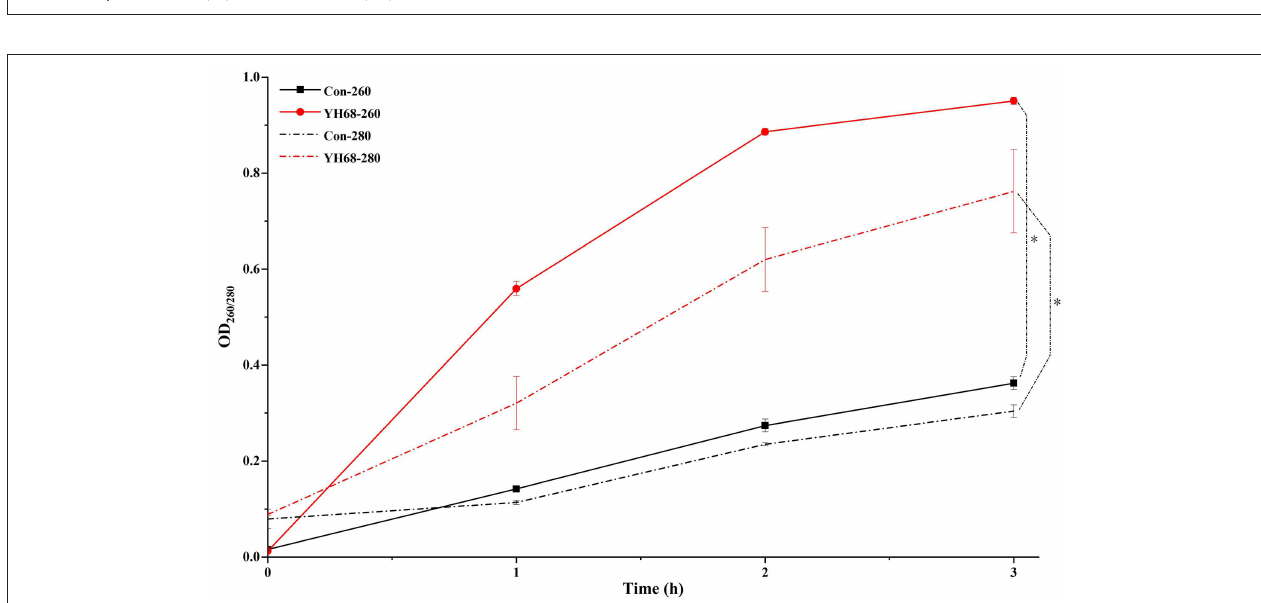
FIGURE 7 | Extracellular UV-absorbing materials from C. difficile ATCC 9689 cells (* P < 0.05; one-way analysis of variance [ANOVA] followed by Tukey’s Multiple Comparison